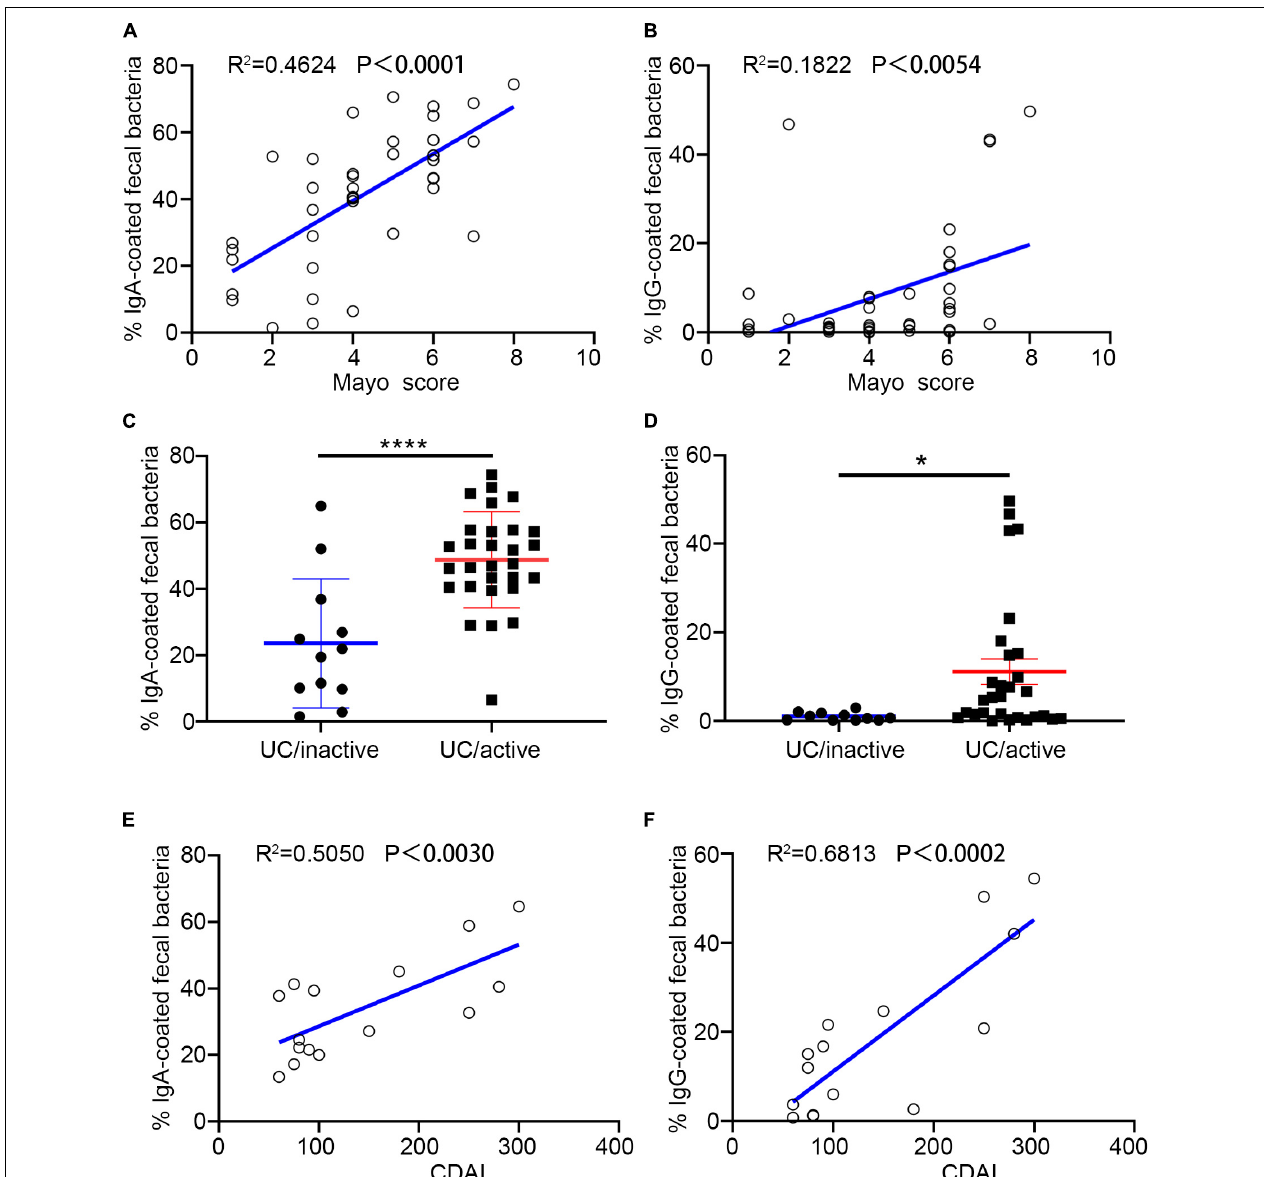
FIGURE 2 | Percentage of Ig + fecal bacteria correlate with IBD activity. (A,B,E) Percentage of IgA + and IgG + fecal bacteria is correlated with ulcerative colitis (UC) activity. (C,D,F) Percentage of IgA + and IgG + fecal bacteria is correlated with CD activity. * p < 0.05, **** p < 0.0001, ns means no significance